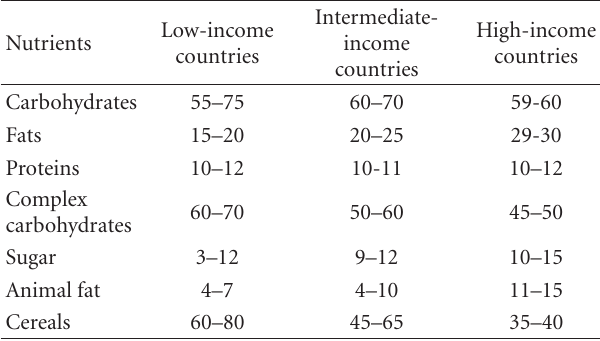
Table 5: Contribution (percentage) of nutrients to Daily Energy Supply (DES) in the EMR